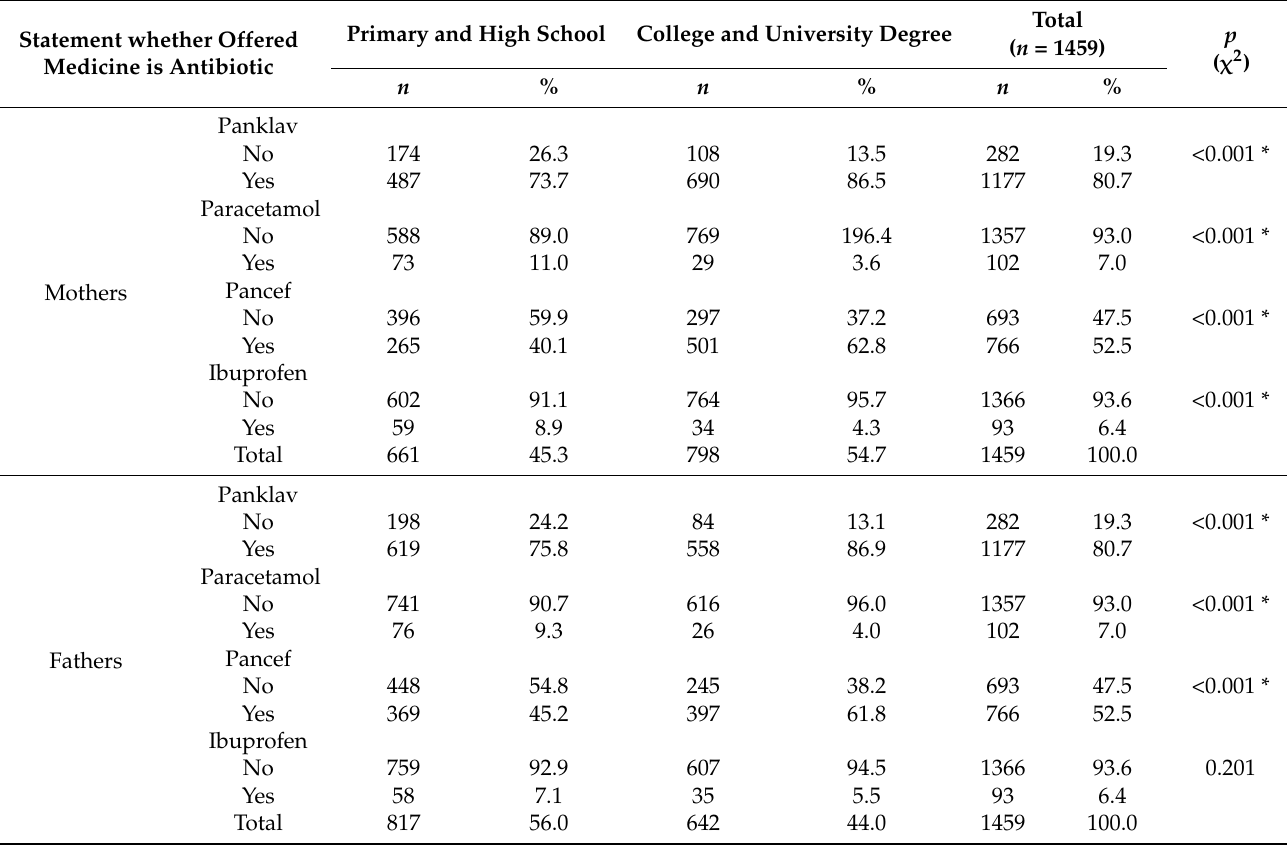
Table 5. Knowledge of parents about antibiotics.